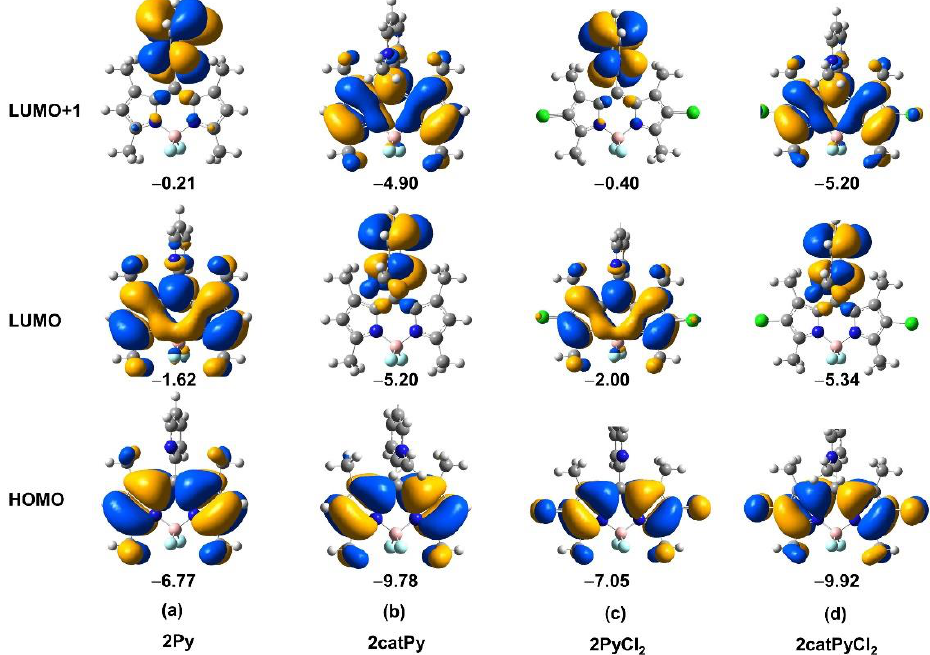
Figure A1. Frontier orbitals of ( a ) 2Py , ( b ) 2catPy , ( c ) 2PyCl 2 and ( d ) 2catPyCl 2 BODIPYs. Orbital energies in eV.